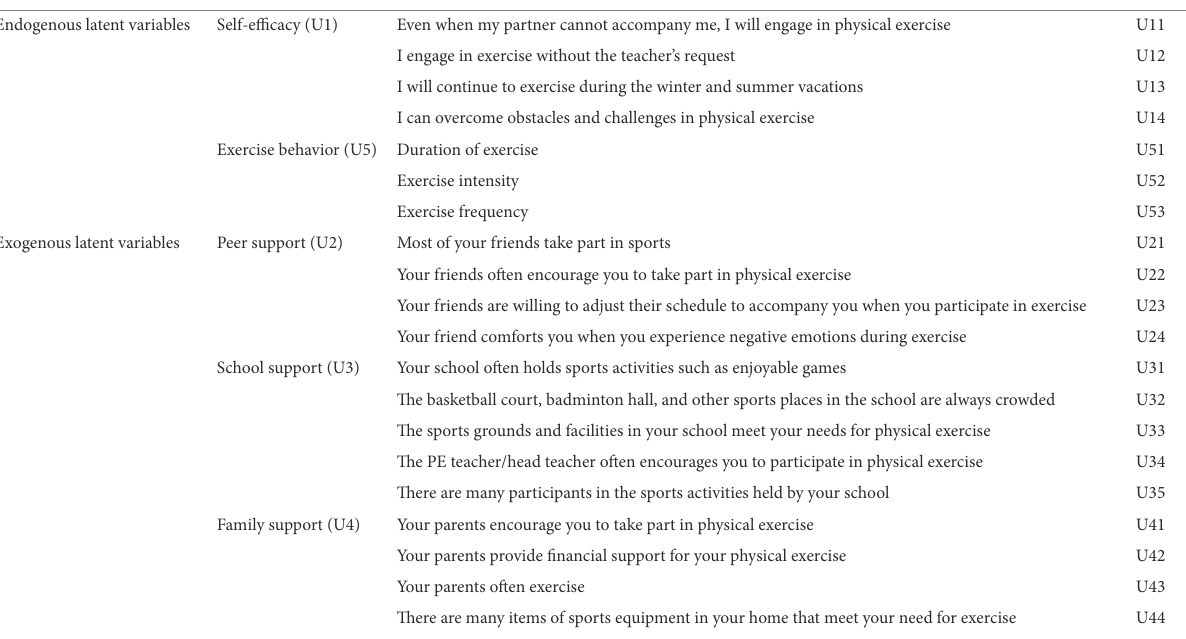
TABLE 1 Questionnaire setting of latent and observed